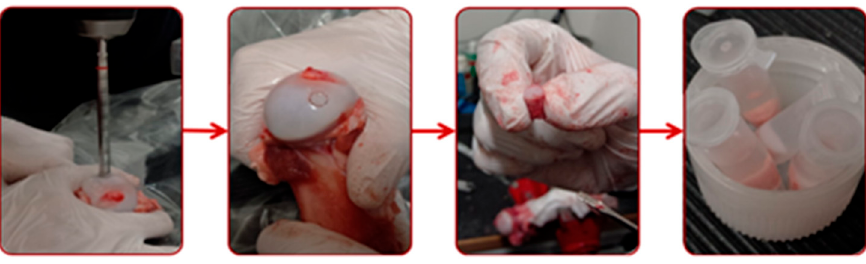
Figure 4. Sampling Figure 4. Sampling process.